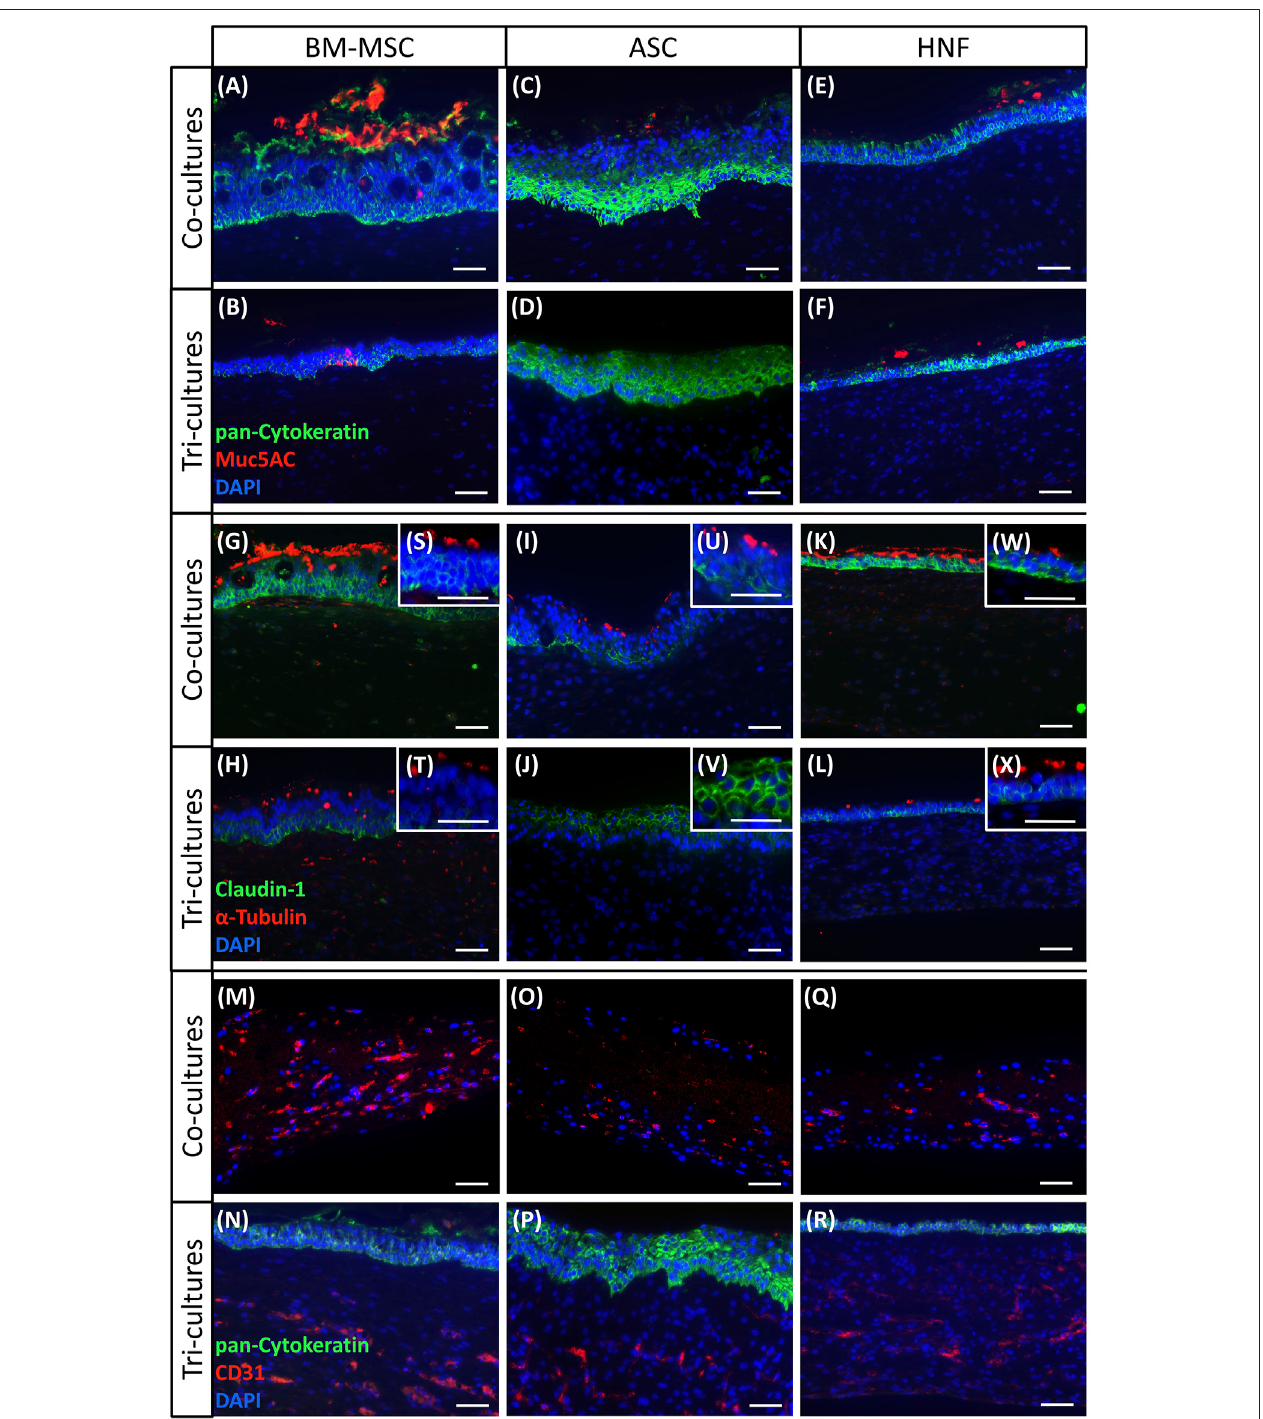
FIGURE 3 | Immunohistochemical staining of co-cultures with HRE, co-cultures with HUVEC and tri-cultures. (A – F) : pan-cytokeratin (green) was used to detect epithelial keratins in all cultures while mucin5AC (red) showed presence of mucus and goblet cells in all cultures containing HRE with BM-MSC (A,B) and HNF (E,F) as well as in HRE-co-cultures with ASC (C) but not in tri-cultures with ASC (D) (G – L) : claudin-1 (green) indicated tight junction formation in all HRE-cultures, and α -tubulin (red) could visualize cilia in all HRE-cultures with BM-MSC (G,H,S,T) and HNF (K,L,W,X) as well as in HRE-co-cultures with ASC (L,U) but not in tri-cultures with ASC (J,V) (M,O,Q) : CD31 staining con fi rmed presence of endothelial cells in co-cultures of HUVEC with BM-MSC (M) , ASC (O) or HNF (Q) (N,P,R) : pan-cytokeratin stained the epithelial cell layer on top of the fi brin gel while CD31 was used to detect endothelial cells and vascular-like structures in tri-cultures containing one of the supporting cell types: BM-MSC (N) , ASC (P) or HNF (R) ; DAPI (blue) was used to counterstain cell nuclei. Representative pictures are shown. Scale bar: 50 µm.